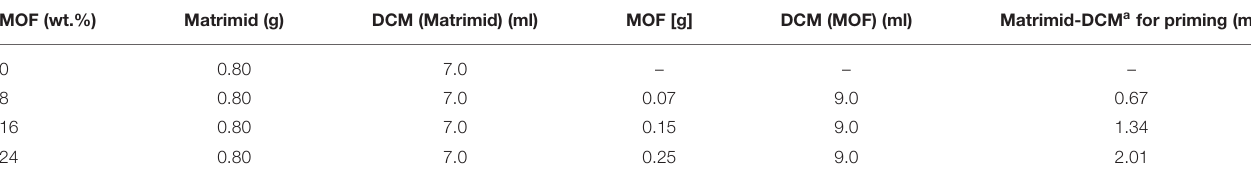
TABLE 2 | Weight and mass content of Matrimid and MOF in mixed-matrix membranes. MOF